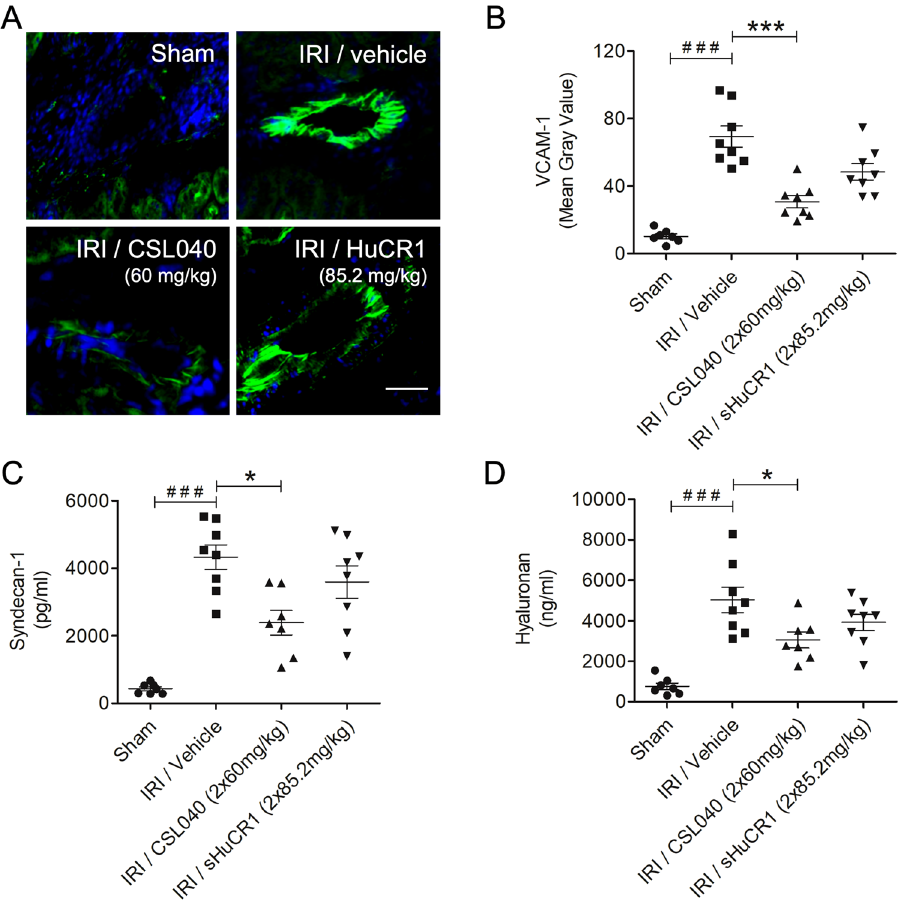
Figure 5. Inhibition of IR-induced endothelial activation and glycocalyx shedding by CSL040 treatment. ( A ) Representative immunofluorescence images of VCAM-1 expression on kidney Sects. 24 h after reperfusion. Scale bar: 30 μm. ( B ) Quantitative analysis of endothelial expression of VCAM-1 by image J analysis. ( C , D ) Plasma levels of syndecan-1 and hyaluronan measured by ELISA. Significance was tested using Mann–Whitney U test ( ### p < 0.001 for sham vs. IRI/vehicle), and One-way ANOVA Kruskal–Wallis test and Dunn multiple comparisons test (*p < 0.05, ***p < 0.001 for IRI/vehicle vs. all treatments). The data shown are mean ± SEM (n = 7–8 per